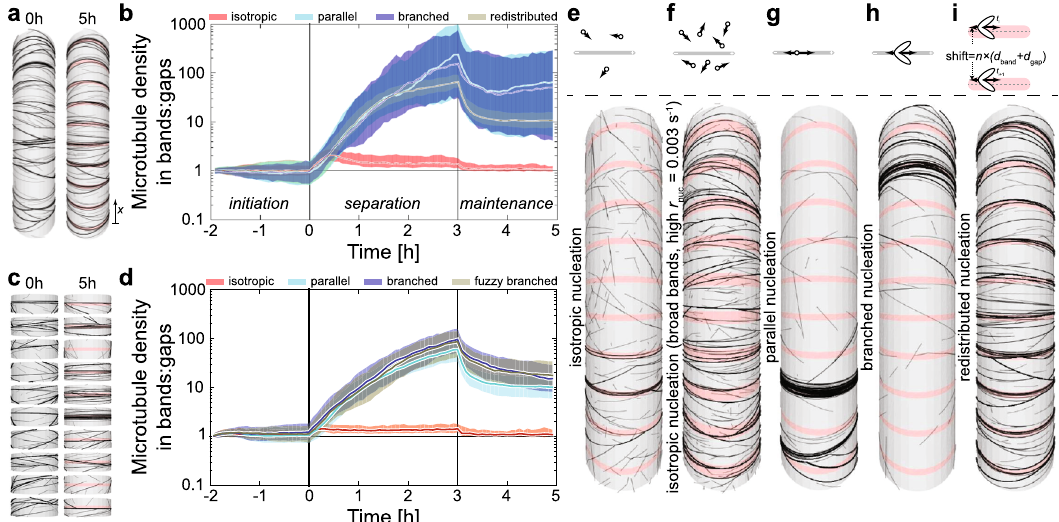
Fig. 2 Simulation of dynamic microtubules reproduces patterning into bands and gaps. a Design of ten-banded cells: microtubules (black lines) are simulated to undergo dynamics on the surface of cylindrical cells. Ten bands (pink) separated by gaps were distributed evenly over the cell surface. The separation phase runs from T = 0 h (left) to 3 h, followed by a 2 h maintenance phase ( T = 5 h, right). b Degree of separation for four different nucleation modes. Lines and margins represent medians ± 16% and 84% percentiles from more than 100 individual simulation runs. c Improved design using ten, independent ‘ single-band ’ models: single bands including their gap environment with a total length of 6 µ m at T = 0 h (left) and T = 5 h (right). All other parameters remained as in a . d Degree of separation for ‘ reconstituted ’ structures for four different nucleation modes. Lines and margins represent medians and 16% and 84% percentiles, respectively, for more than 100 ‘ reconstituted ’ structures comprised ten unique single-band models obtained from 2000 independent simulations. e – i Top row: schematic representations of the fi ve different nucleation modes: isotropic ( e ), isotropic with threefold higher nucleation rate and 2 µ m-wide bands ( f ), parallel ( g ), branched ( h ) and redistributed nucleation ( i ). A microtubule is depicted as a grey rod with plus and minus ends. Arrows indicate the direction of polymerization from a nucleation site. Elliptic areas depict orientation bias for branched nucleation of ~35° relative to the microtubule axis. Redistributed nucleation involves determination of nucleation site as with parallel nucleation, followed by a shift of a random integer times the length of the repeating unit ( d band + d gap ) leading to global redistribution of the nucleation sites, while maintaining relative position to the nearest band centre. Lower row of panels shows snapshots of representative simulations for each nucleation